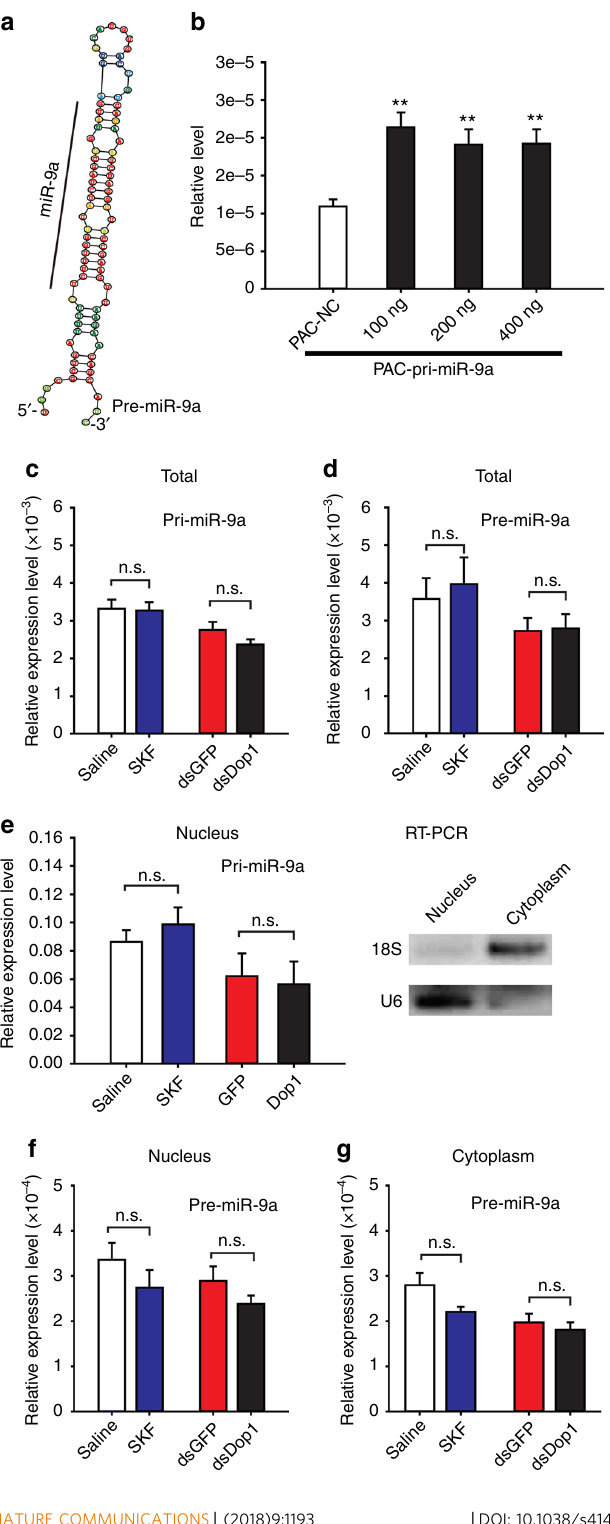
Fig. 7 Dop1 does not affect the expression of primary miR-9a (pri-miR-9a) and miR-9a precursor (pre-miR-9a). a Predicted stem – loop structure of pre-miR-9a. b Expression of miR-9a in S2 cells transfected with expression vectors including partial sequence of pri-miR-9a centered pre-miR-9a ( n = 6). c , d Expression levels of pri-miR-9a ( c , n = 8) and pre-miR-9a ( d , n = 8) in total cells after activation and inhibition of Dop1, respectively. e Expression levels of pri-miR-9a in the nucleus after activation and inhibition of Dop1, respectively. U6 was used as a nuclear marker and 18 S rRNA as a cytoplasmic marker. f , g Expression levels of pre-miR-9a in the nucleus ( f , n = 8) and cytoplasm ( g , n = 8) after activation and inhibition of Dop1, respectively. The asterisks outside the strip indicate the signi fi cant difference between controls and the treatments through Student ’ s t -test and presented as the mean ± SEM. ** P < 0.01. n.s.: not signi fi cant,